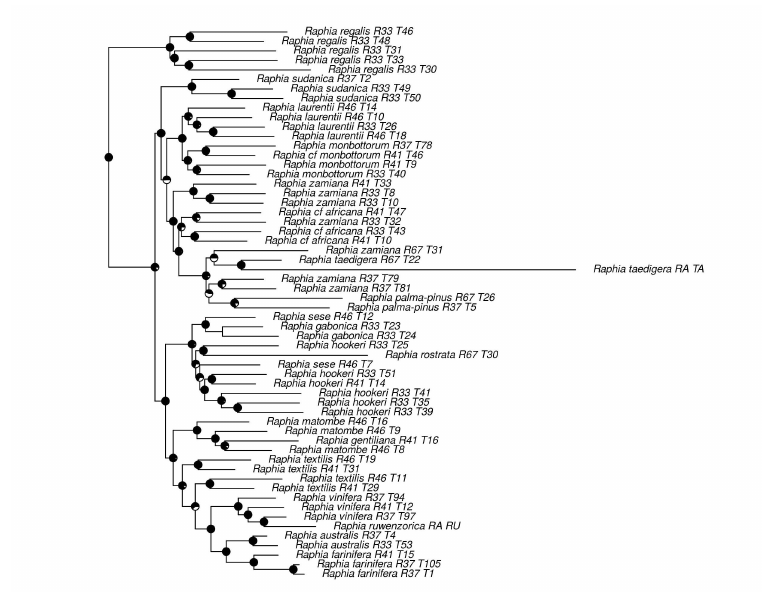
Figure A1. IQTREE Raphia inferred using 162 kb of sequence data. Values for ultrafast bootstrap support are depicted on nodes.